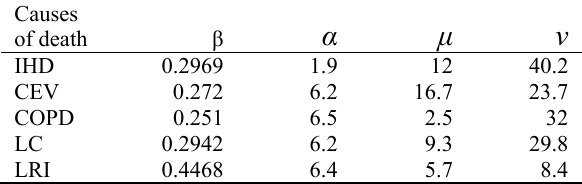
Table 1 . Parameter estimates for GEMM (Burnett et al. 2018).